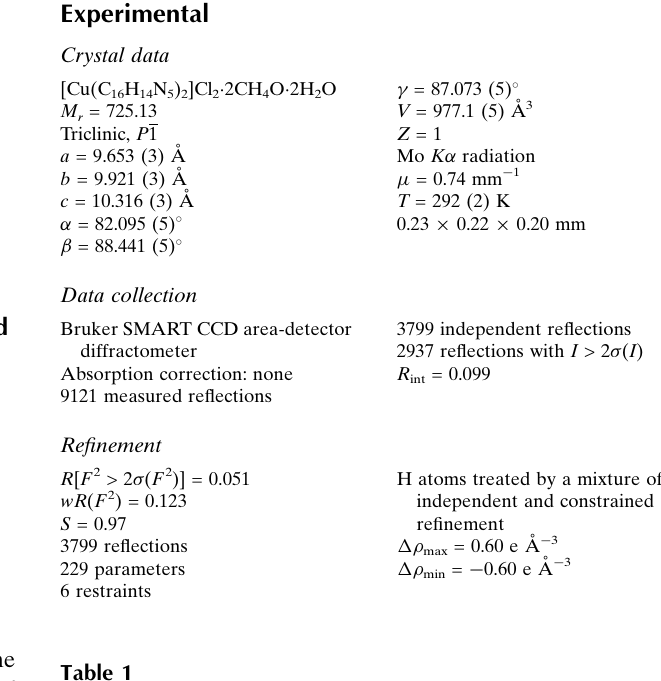
Hydrogen-bond geometry (A˚ , (cid:2)